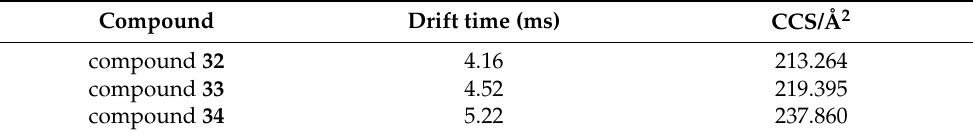
Figure 8. Chemical Structure of compounds 32 , 33 , and 34 . Table 1. Drift times of compounds 32 , 33, and 34 by UHPLC-IM-MS and CCS calculated from the drift